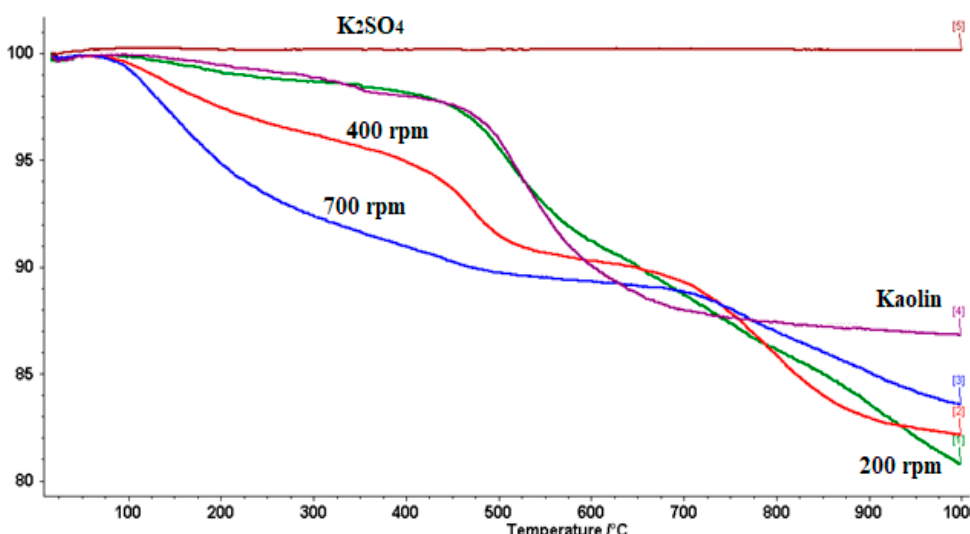
Figure 6. TGA patterns of kaolinite-K 2 SO 4 samples with multiple milling speeds for 120 min.